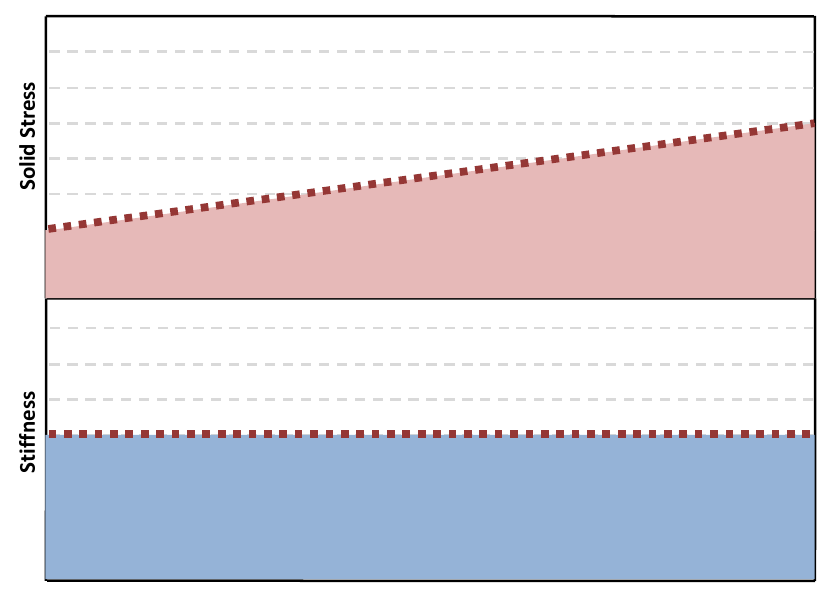
Figure 4. Solid stress and stiffness as a function of tumour diameter (adapted from Nia et al.) [201]. As rigidity of the ECM remains constant, an increase in tumour diameter is associated with increased solid stress within the tumour.